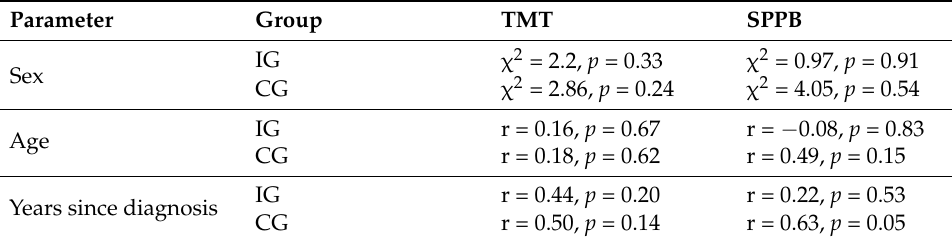
Table 3. Correlation between functional ability scores and patients’ characteristics.